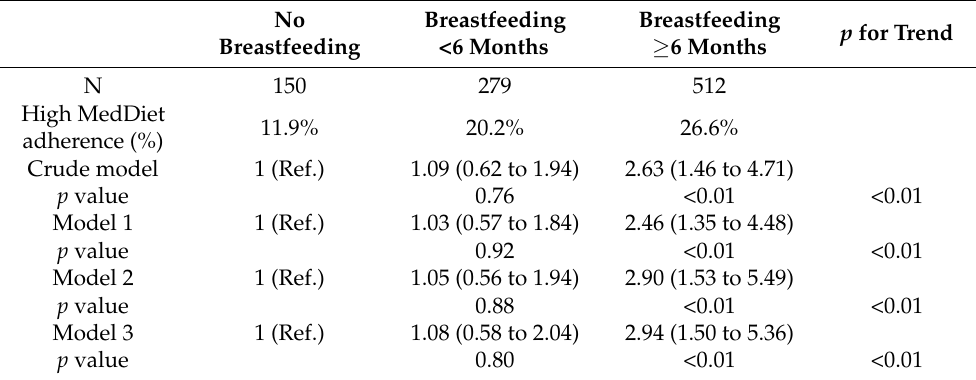
Table 3. Odds ratio (OR) and 95% confidence interval (CI) for high adherence to the Mediterranean dietary pattern (KIDMED score ≥ 8) associated with breastfeeding